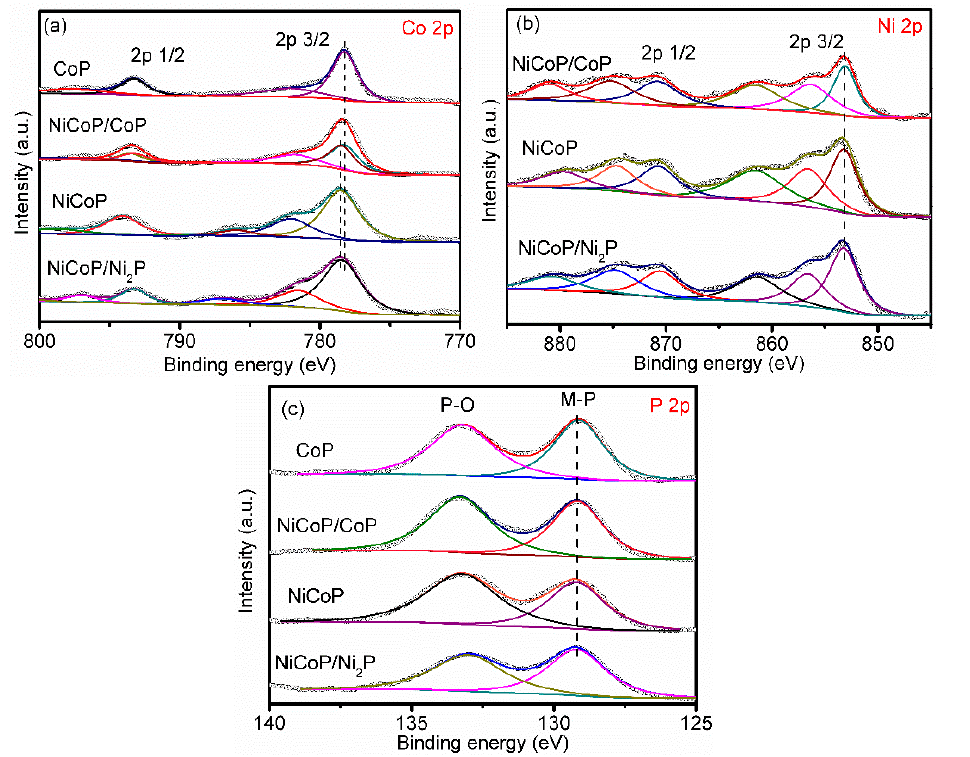
Figure 4. The high-resolution Co 2p ( a ), Ni 2p ( b ) and P 2p ( c ) XPS spectra of CoP, NiCoP/CoP, and NiCoP, respectively.